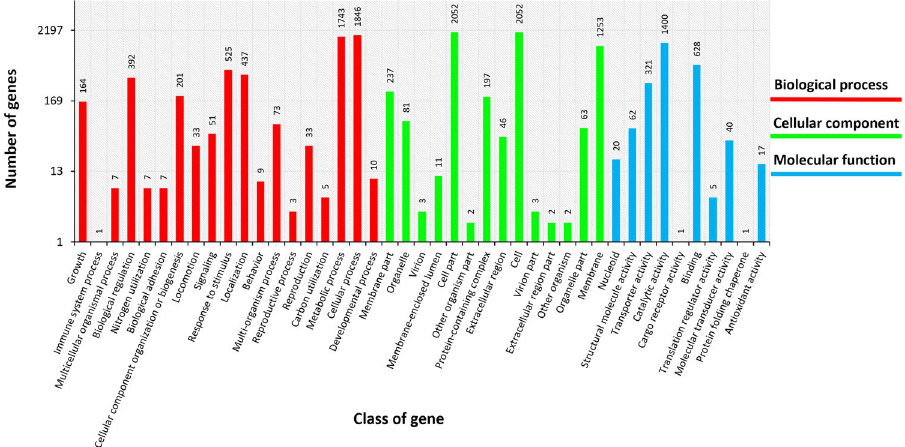
Figure 3. GO analysis of Enterobacter aerogenes LU2. Colored bars indicate the number of genes assigned to each class of